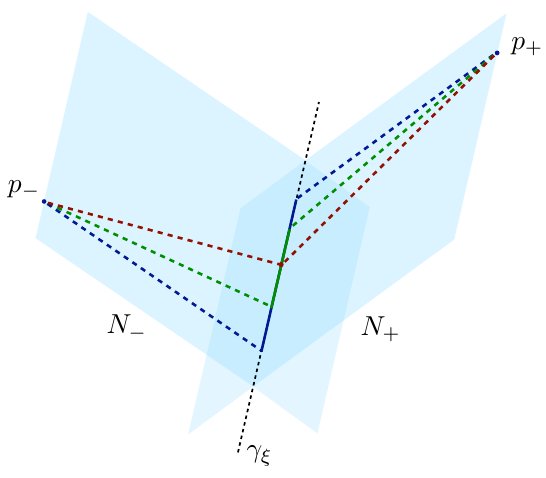
Figure 3 . Deformations (green and red) of the swing surface (blue) in N + ∪ N − . The dashed lines are ropes and the solid lines are benches. The ropes of the original swing surface are null while the deformed ones are spacelike. Note that the bench of the red surface has shrunk to a point. Such deformations preserve the area when the expansion θ on N + ∪ N − vanishes and decrease the area when θ is